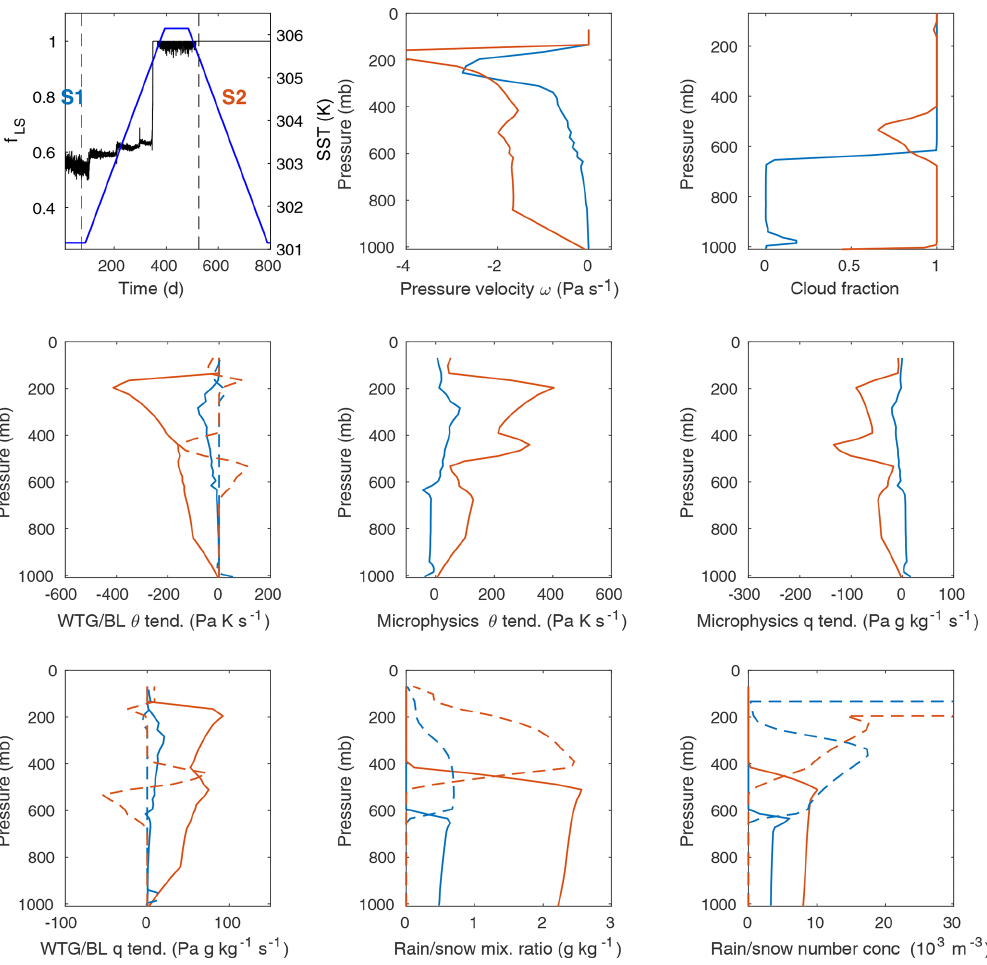
Figure 9. An experiment showing f LS → 1. The left axis of the top left plot shows f LS for the WRF SCM over the heating phase of an 800d integration with the WTG approximation active, a background profile calibrated for 301.15K SST, and SST forcing from 301.15K (28 ◦ C) to 305.15 K. A typical quasi-stationary state (S1, blue) and the f LS = 1 state (S2, red) are indicated. The right axis shows SST for the integration. The remaining plots show vertical profiles for the labeled quantities, averaged over time for each of the two states. In the WTG or boundary layer (BL) panels, solid lines show the WTG relaxation forcings, and dashed lines show the boundary layer forcings. In the plots for rain or snow mixing ratio and number concentration, solid lines represent rain, and the dashed lines represent snow. See